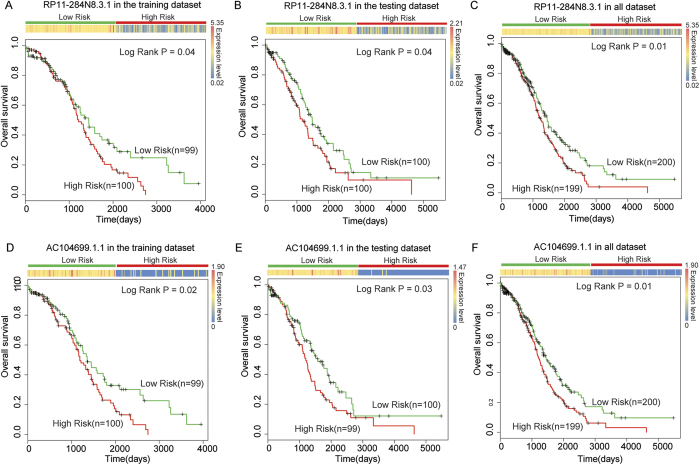
The use of lncRNAs to predict the clinical outcomes of OV patients.The expression profile of the lncRNAs is shown in the top panel. The corresponding Kaplan-Meier survival plot (bottom) of the two patient subgroups. Patients who showed no progression or who were still alive at the time of the last follow-up were censored (+). Survival days are shown along the x-axis. Overall survival rates are shown along the y-axis. LncRNA RP11-284N8.3.1 was able to distinguish patients with different clinical outcomes in (A) the training dataset, (B) the testing dataset and (C) the combined dataset. LncRNA AC104699.1.1 was able to distinguish patients with different clinical outcomes in (D) the training dataset, (E) the testing dataset and (F) the combined dataset.